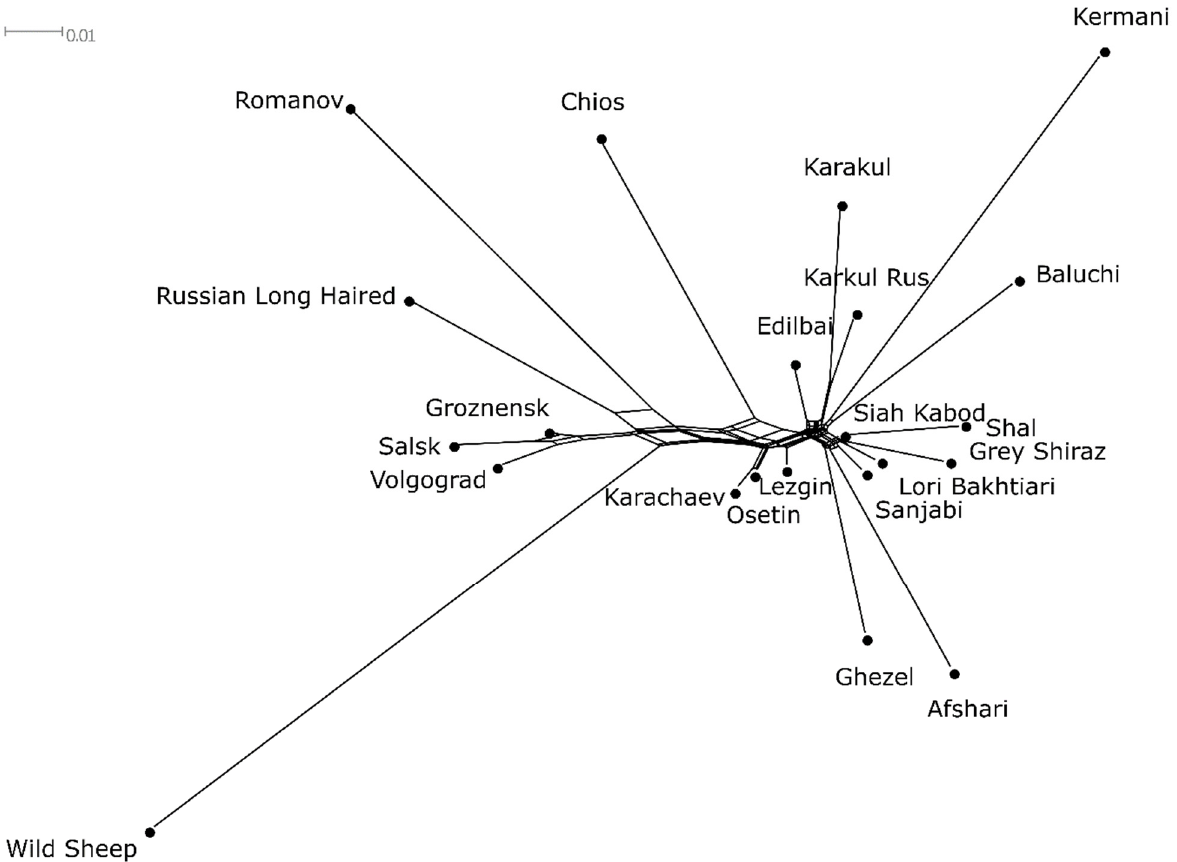
Figure 2. Neighbor-Net graph for Iranian and Russian local sheep breeds. Clustering with Admixture software showed that, at K = 2, the Romanov, Volgo- grad, Salsk, Groznensk, and Russian Long-Haired breeds had a different ancestral back- ground from Iranian local and other Russian breeds (Figure 3).